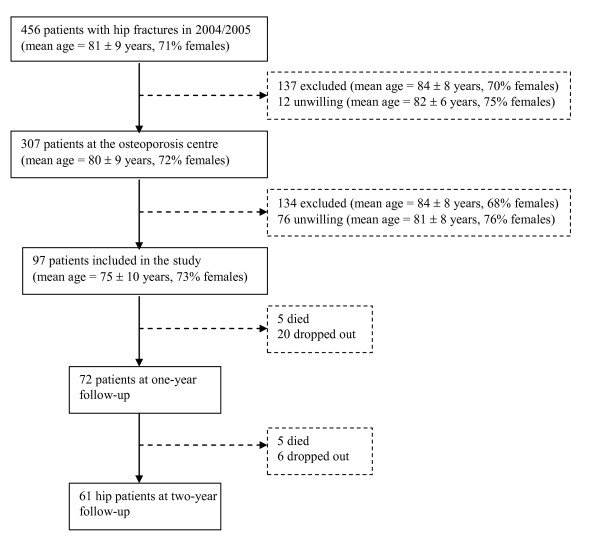
Flow chart of the patients with hip fractures at baseline and at one- and two-year follow-up.